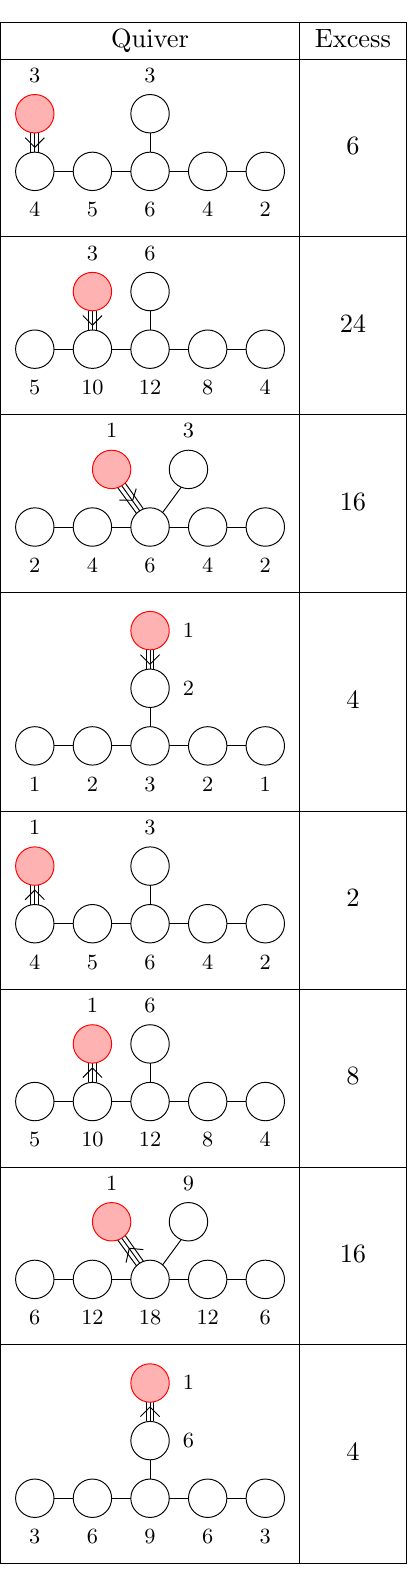
Table 19 . Exotic minimally unbalanced quivers of E 6 -type with a triple laced